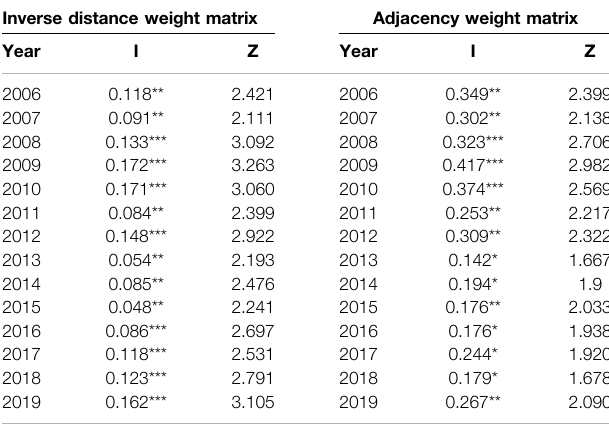
TABLE 11 | The calculation results of the global Moran index.